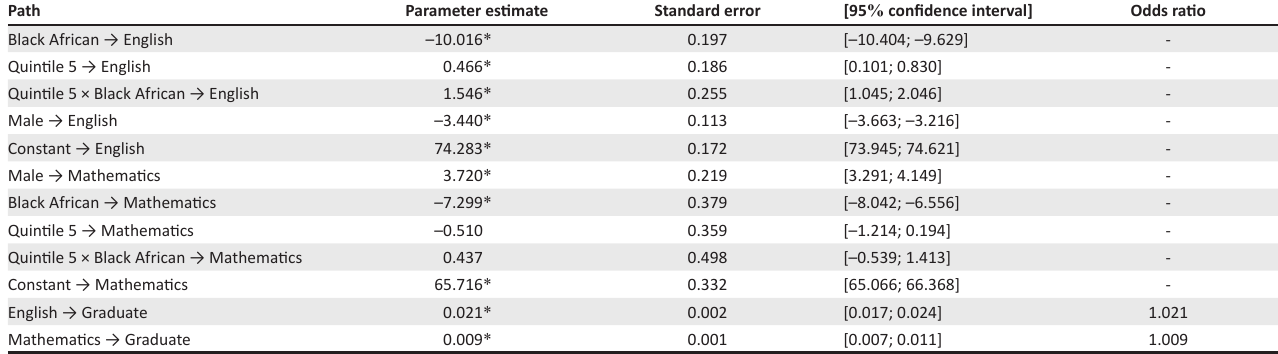
TABLE 8: Indirect effect estimates that are mediated through Mathematics and English.